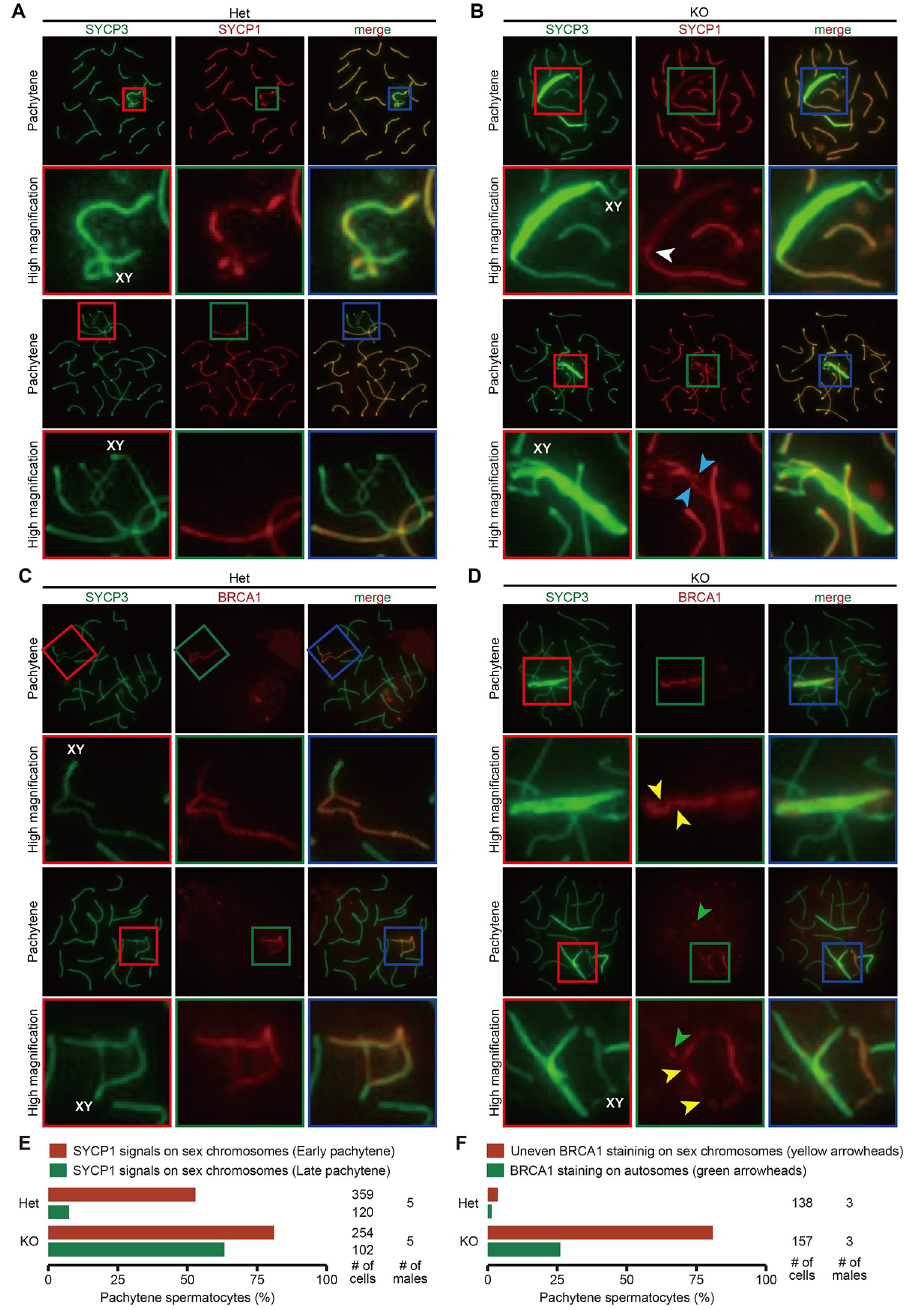
Fig 5. Synapsis configuration of SYCP3 overloaded axes. (A and B) SYCP1 immunostaining of spread nuclei of prophase spermatocytes collected from adult Het (A) and KO (B) male mice. High magnified images for the sex chromosomes are shown in red, green, and blue boxes. The sex chromosomes were identified by their characteristic shape of SYCP3 axes. A white arrowhead indicates a seamless connection of SYCP1 signals between the sex chromosomes and autosomes. Blue arrowheads show SYCP1 signals remaining on the sex chromosomes until the late pachytene stage. At least three male mice were analyzed. (C and D) BRCA1 immunostaining of spread nuclei of prophase spermatocytes collected from adult Het (C) and KO (D) male mice. High magnified images for the sex chromosome were shown in red, green, and blue boxes. Yellow arrowheads indicate BRCA1 missing from the sex chromosome. Green arrowheads show BRCA1 located on autosomes. At least three male mice were analyzed. (E) Quantification data for SYCP1 staining. Red and green bar graphs indicate the percentage of early and late pachytene spermatocytes with SYCP1 signals outside of the pseudoautosomal region of sex chromosomes, respectively.